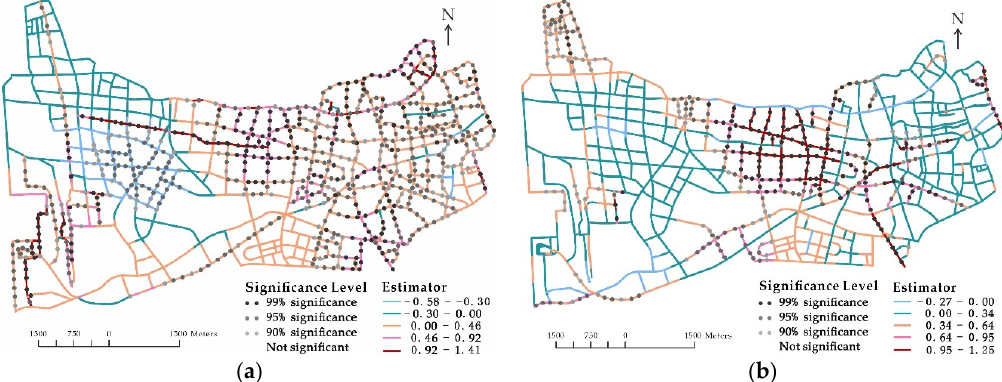
Figure 2. Spatial distribution of coefficient estimations and significance levels by exposure variable. ( a ) vehicle_km and ( b ) num_elder.